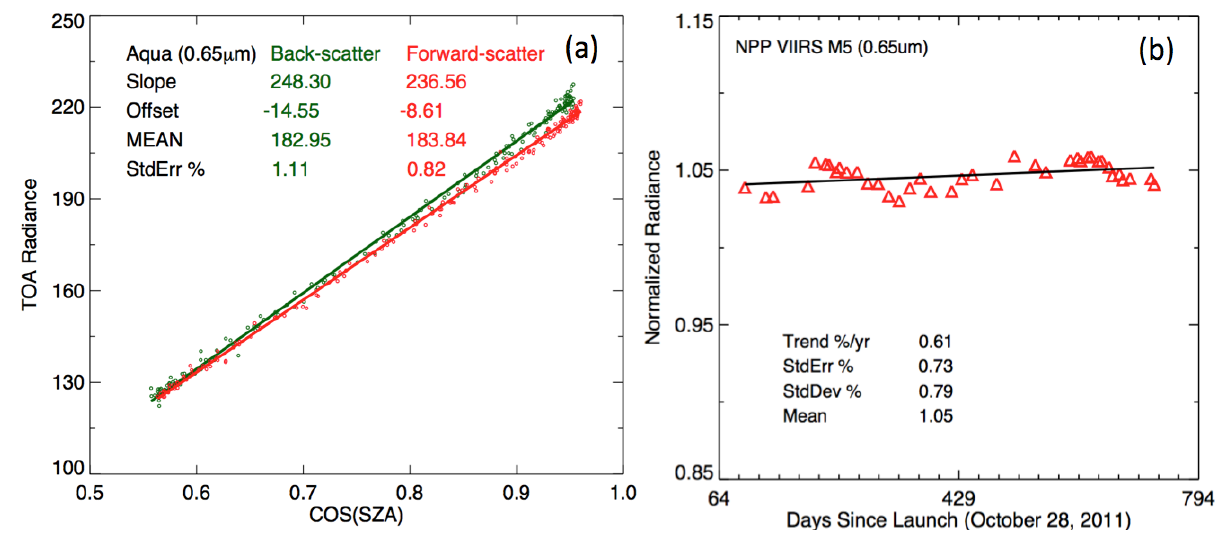
Figure 2. ( a ) Linear BRDF regression models derived from near-nadir TOA radiance measurements from Aqua-MODIS band 1 over Libya-4 (2002−2013) for forward (in red) and back scattering directions (in green); and ( b ) the VIIRS M5 observed divided by the predicted BRDF modeled in (a) radiance ratios before the normalization of the ratios over the VIIRS